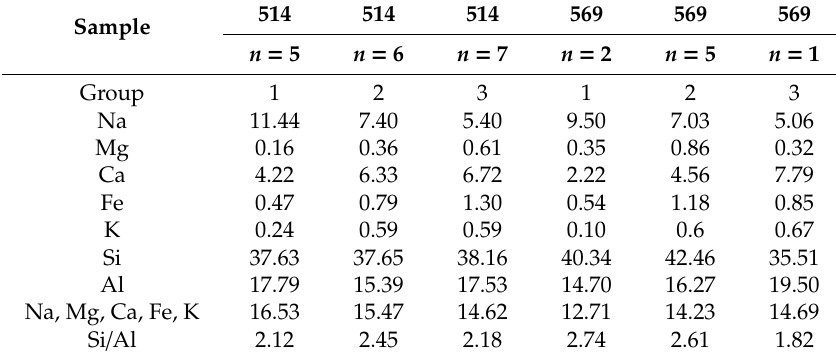
Table 1. EDS analyses (atom %) of Na-rich grains from samples 514 and 569 arbitrarily divided into three groups (see text) according to their Na atom %